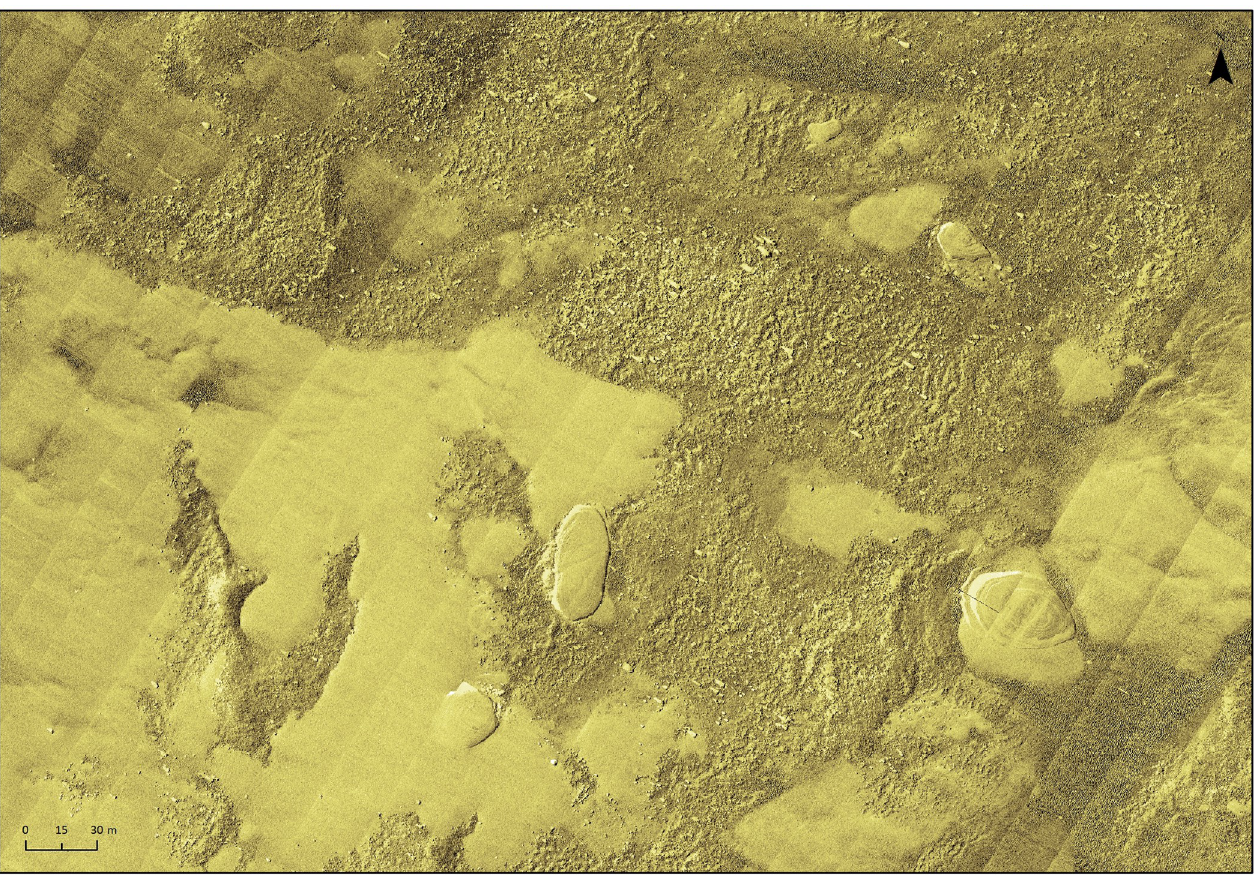
Fig 9. Side-scan sonar image of seabed consisting of various sediment